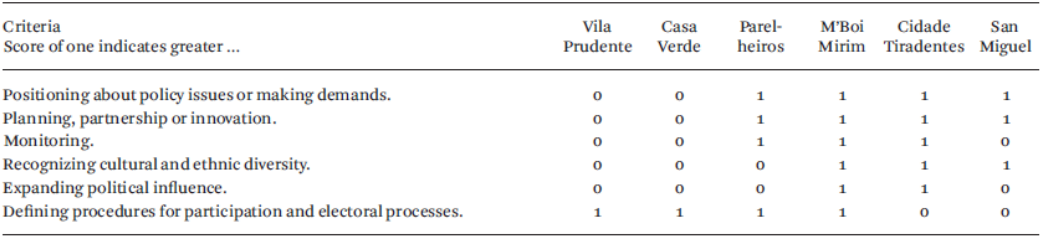
Tab. 4 - Type of theme debated in six LHCs in areas with different histories of mobilization